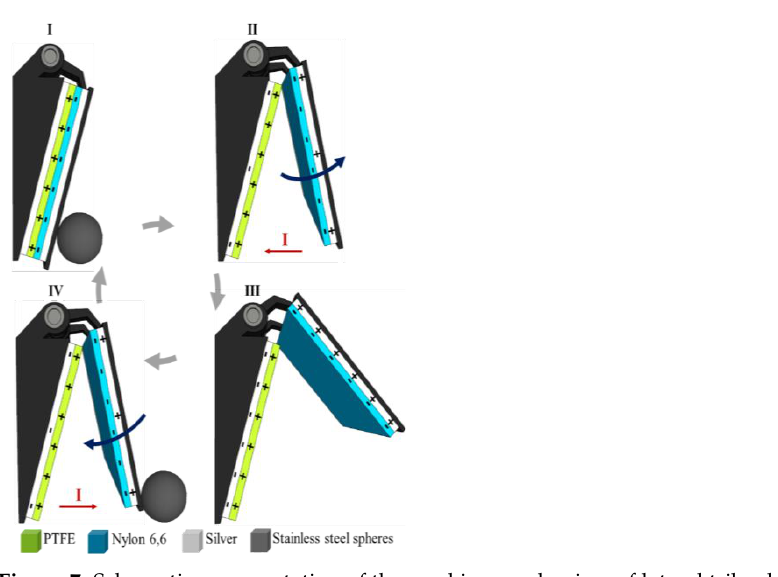
Figure 7. Schematic representation of the working mechanism of lateral triboelectric nanogenerator. Under the excitation of ocean waves, the spheres roll and, when hitting the lateral ends of the trough, make the Nylon 6,6 and PTFE films come into contact with one another, becoming charged by contact electrification. With the tribo-generator fully closed, the electrostatic equilibrium is attained, there are no induced charges on the electrodes and the current is zero (Figure 7-I). When the PLA supporting substrates begin to open, a